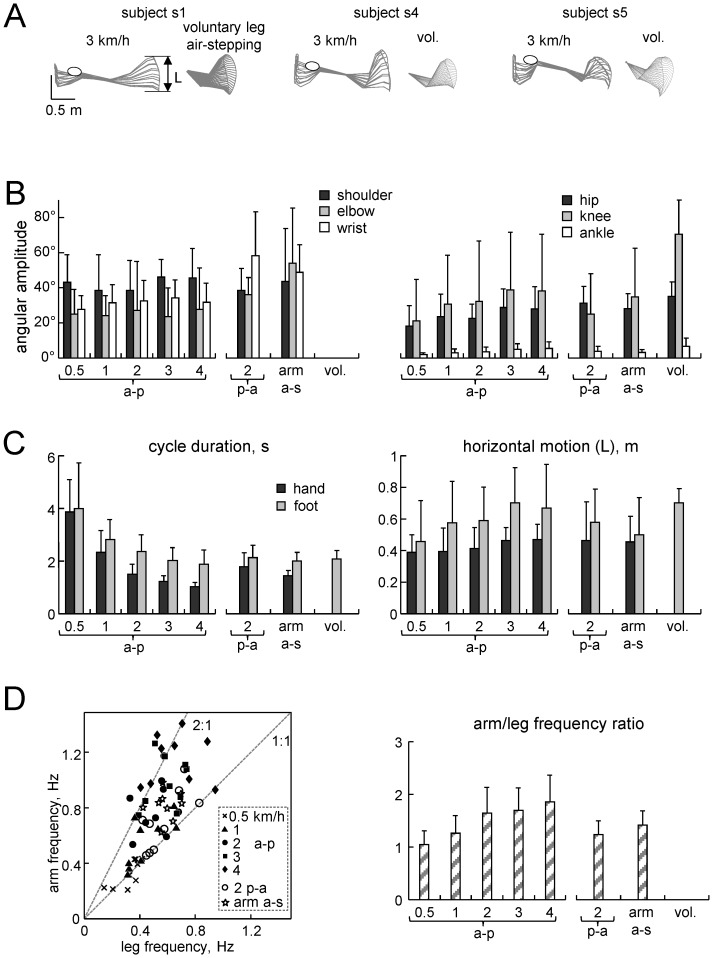
General gait parameters.A – stick diagrams of left arm and leg movements in three different subjects during hand-walking at 3 km/h in the a-p direction (left) and voluntary (vol.) air stepping (right). B – mean (+SD, n = 9) arm and leg joint angular amplitudes across different hand-walking speeds in the a-p direction (left) and different conditions of the main protocol: hand-walking at 2 km/h in the p-a direction, arm air-stepping (arm a-s) and voluntary leg air-stepping. C – cycle duration and a-p foot excursion. D – frequency relation between arm and leg movements. In scatter plots each point illustrates the arm or leg movement frequency during different conditions for each single participant. The dotted lines indicate integer arm:leg frequency ratios (1∶1 and 2∶1). Bars in the right panel represent mean (+SD) arm/leg frequency ratios over all conditions.